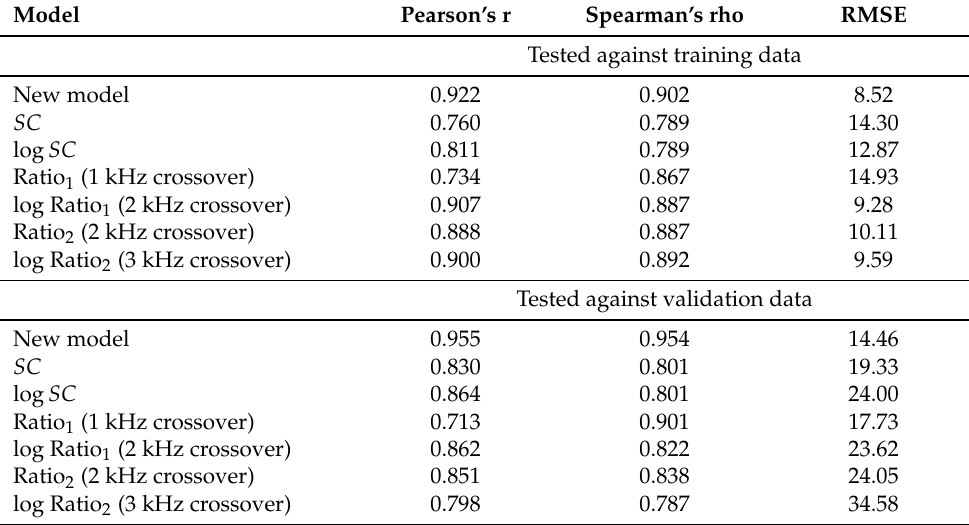
Table 3. Comparing the performance of all brightness